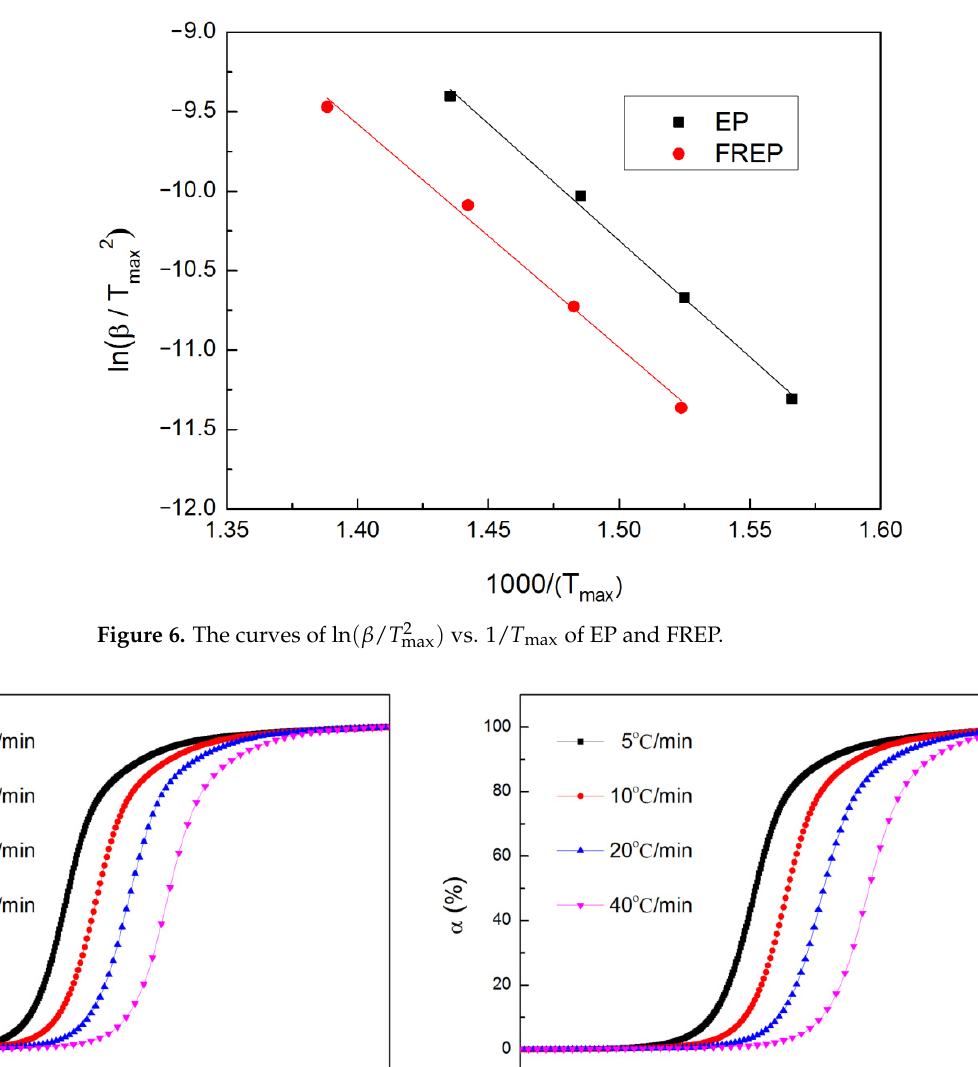
Figure 8. The curves of lg( ) β vs. 1/T of EP ( a ) and FREP ( b ). The values of E vs. α were exhibited in Figure 9. For pure EP, the changes of activa- tion energies were minimal in the range of conversion rates from 0.02 to 0.80, so that ki- netic parameters could be regarded as fixed. When α > 0.8, an obvious change of E oc- curred, which was related to the formation of the char layer and to the change in kinetic parameters. Compared with the E of pure EP, the variation of FREP had a similar law and the E of thermal degradation increased with the increase of the α . However, the E values of FREP were higher than that of pure EP in the final stage, which suggested that it was closely related to the formation of the final char residue layer.